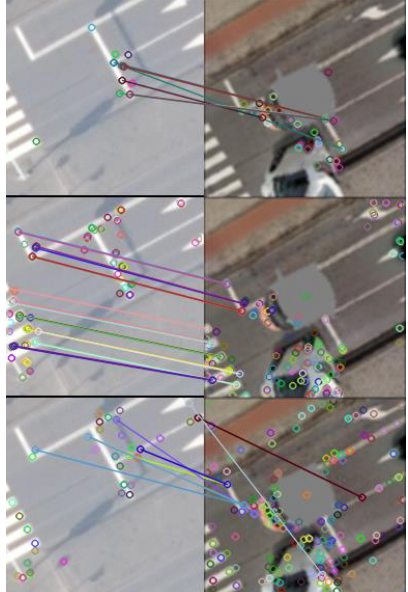
Figure 14 Comparison of matching results of AKAZE (top), KAZE (centre) and SIFT (bottom) in 4th run of the 2nd scene